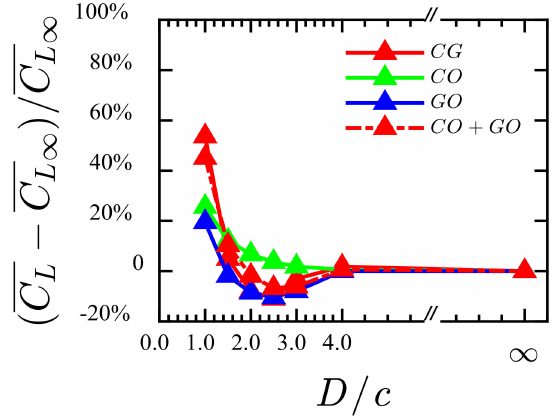
Figure 19. The relative increment of cycle-averaged lift coefficient relative to the D / c = ∞ case (cid:0) (cid:1) C L − C L ∞ (expressed as / C L ∞ ) for the combined ceiling and ground case (referred to as CG ), ceiling-only case (referred to as CO ), and ground-only case (referred to as GO ), and the sum of the ceiling-only case and the ground-only case (referred to as CO + GO ) versus wall clearance ( D / c ) at Re =